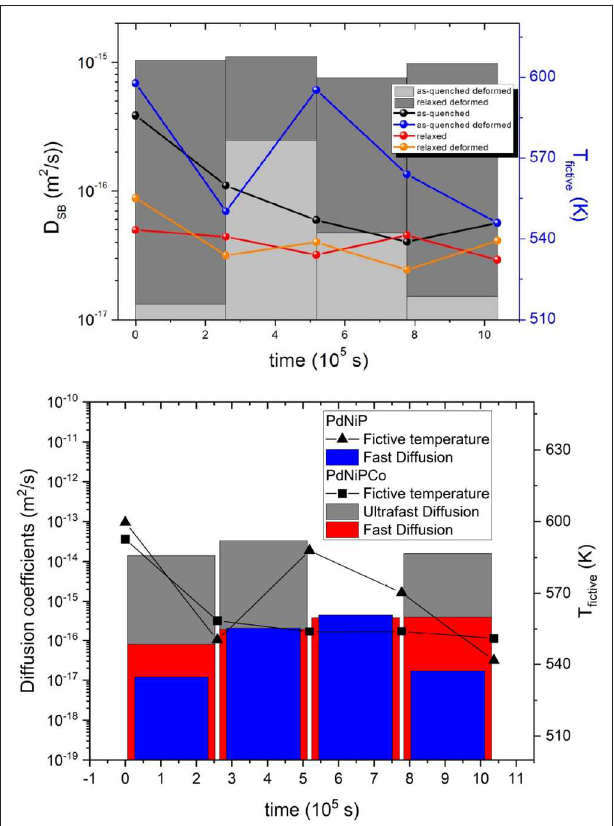
FIGURE 7 | Time dependence of diffusion enhancement in model PdNiP glass deformed by cold-rolling as compared to that in PdNiP preliminary relaxation annealed (Top) or to as-quenched Co-microalloyed PdNiP glass (Bottom) . Further, the time dependencies of the diffusion coefficients are compared with that of the fictive temperature T fictive of the BMGs. The systematic uncertainty of a single diffusion experiments can be approximated to be about 50%. These are not shown for better visibility of the